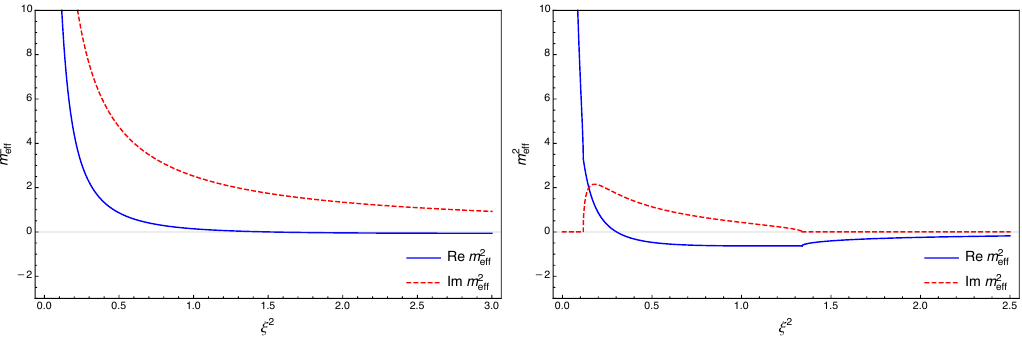
Figure 8 . Behavior of the argument of W in (6.19) for the tachyonic theory.